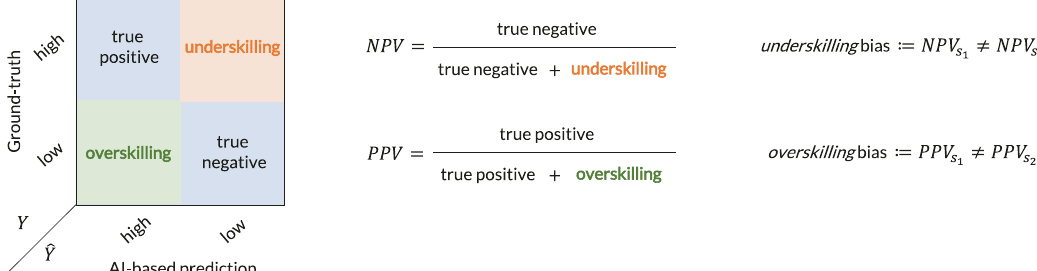
Fig. 6 Visual de fi nition of underskilling and overskilling bias in the context of binary skill assessment. Whereas an underskilling bias is re fl ected by a discrepancy in the negative predictive value of AI-based predictions across sub-cohorts of surgeons (e.g., s 1 = novice and s 2 = expert), and overskilling bias is re fl ected by a discrepancy in the positive predictive